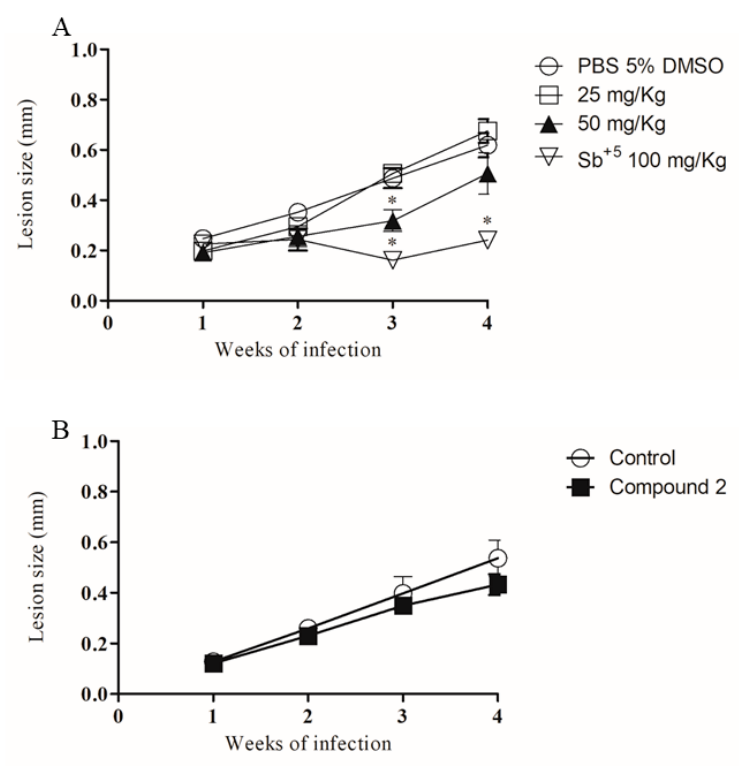
Figure 7. Pharmacological effect of compound 2 in an experimental model of cutaneous leishmaniasis. BALB/c mice were infected with 10 6 L. amazonensis promastigotes in the stationary growth phase and lesion development was monitored for four weeks. Lesion size is expressed as mean ± SD of eight animals per group during the treatment by oral ( A ) or topical ( B ) route. * p < 0.05 (two-way ANOVA, followed by Bonferroni’s multiple comparison test).